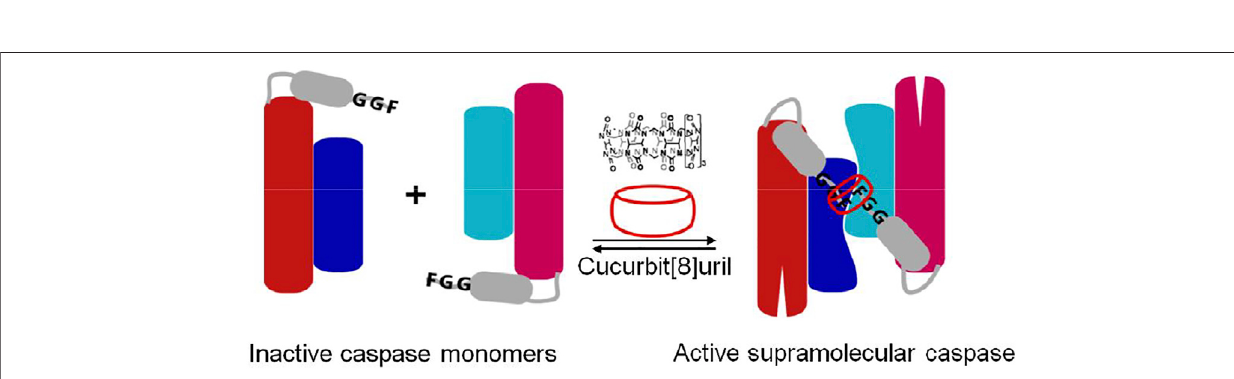
FIGURE 8 | Schematic representation of N-terminal FGG-bearing (grey) monomeric caspase-9 (red: large subunit, blue: small subunit) and its dimerization into an enzymatically active homodimer by cucurbit[8]uril (Dang et al., 2013).